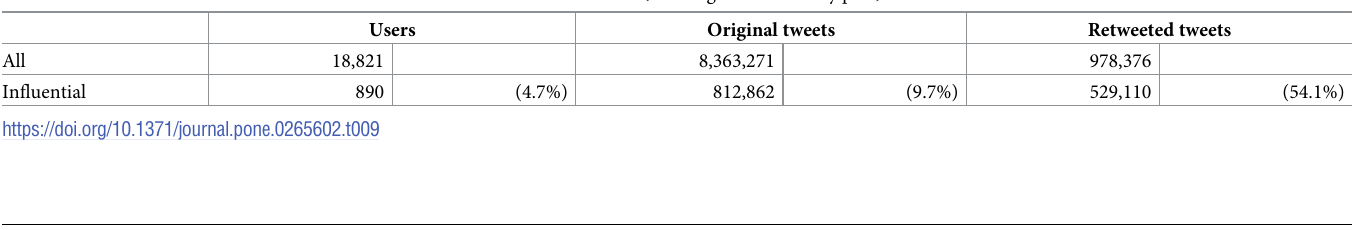
three major categories: Individual, Organization, and Unverified. The Unverified label is not meant as the opposite of the Twitter verification label, but just lumps together the users for which the identity was unclear (Anonymous), their accounts were closed (Closed) or sus- pended by Twitter (Suspended). The Individual and Organization accounts are further catego- rized into subtypes. Table 8 provides the categorization of 890 users into types and subtypes. We selected the top users from the major communities, ranked by their retweet h-index. When the user did not switch between the communities (in 644 out of 890 cases, 72%) we assign its prevailing community across the whole time period from the community membership at individual timepoints. We introduce an additional transition community, Left ! SDS, that encompasses Twitter accounts which switched from the Left community to the current government SDS community at the time of the government transition from the left-wing to the right-wing. This transition community consists mostly of governmental accounts (ministries, army, police, etc.) and demonstrates surprisingly well how detected communities in time reflect the actual changes in the political landscape. The 890 users, classified into different types, represent less than 5% of all the users active on Slovenian Twitter during the three year period. However, they exhibit the bulk of the retweet influence. They posted almost 10% of all the original tweets, and, even more indicative, over 50% of all the retweeted tweets were authored by them. The details are given in Table 9. Fig 7 shows how many unacceptable tweets are posted by different user types and subtypes. Over 40% of tweets posted by unverified accounts are unacceptable. In this category, the sus- pended accounts lead with over 50% of the tweets classified as unacceptable. This demonstrates Table 9. Influential users. The share of influential users in terms of their number, the original tweets they post, and their tweets that were